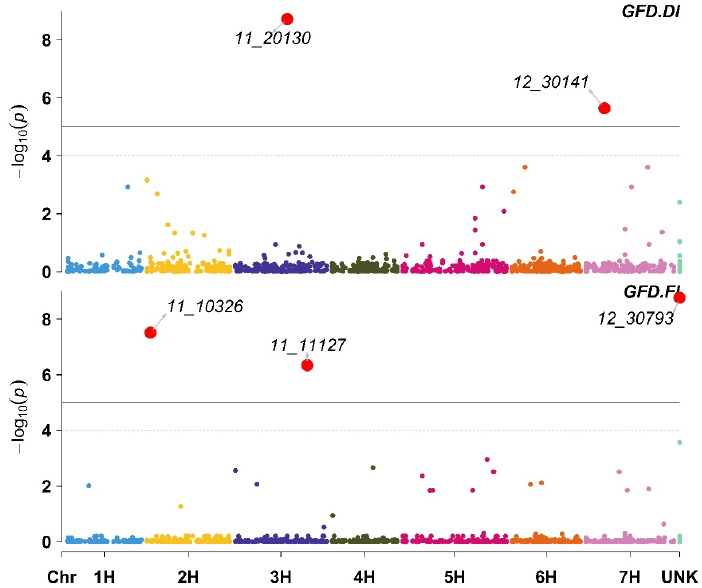
Figure 4. Manhattan plot displaying the results of the genome-wide association scan (red dots annotated dots refer to significant markers or markers with − log10 (p) more than 5, while the green dots refer to non-significant markers but have − log10 (p) between 4 and 5) for the Grain-Filling Duration (GFD) using 426 barley lines under Deficit Irrigation (GFD.DI, upper plot) and Full Irrigation (GFD.FI, lower plot).